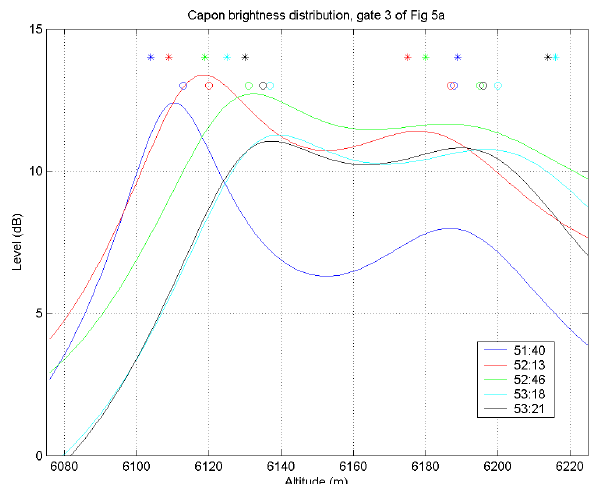
Fig. 6. Capon brightness distribution for 5 consecutive records from time 51:40 to 53:21 and for gate 3 of Fig. 5a where a double peak is observed. The stars and circles indicate the corresponding positions given by MEM and the MUSIC algorithm,